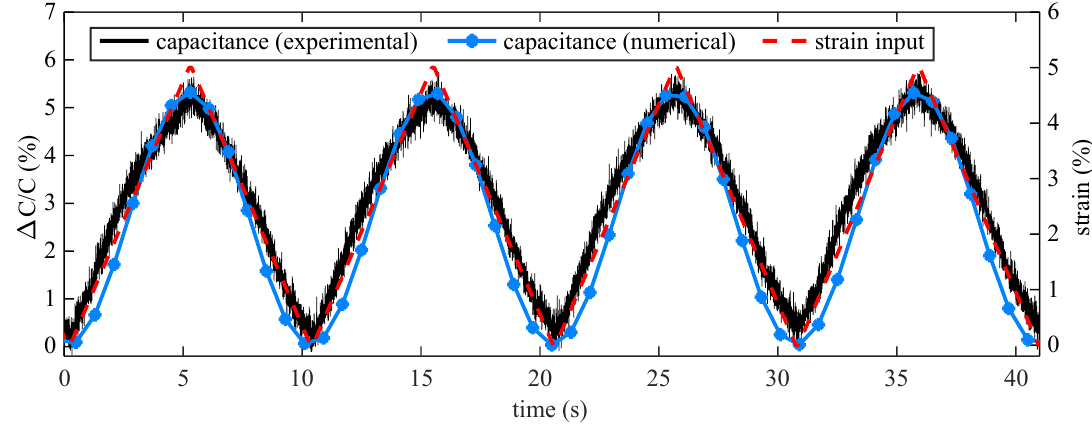
Figure 6. Time series responses of Pattern F adhered partially onto canine